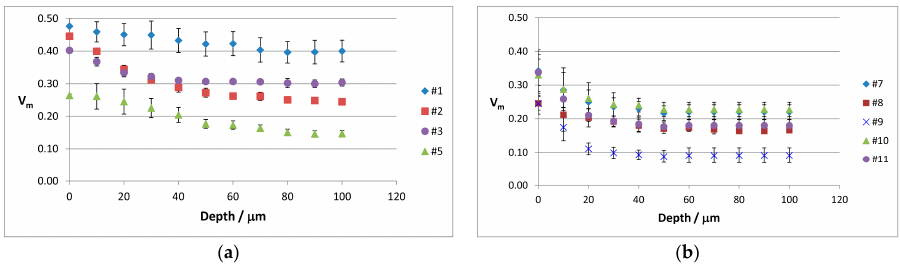
Figure 6. The trend of the V m monoclinic content as a function of depth in the MT area of femoral heads ( a ) #1, #2, #3, #5; and ( b ) #7, #8, #9, #10, and #11. Each point represents the average value of three to five different measurements carried out in different points.